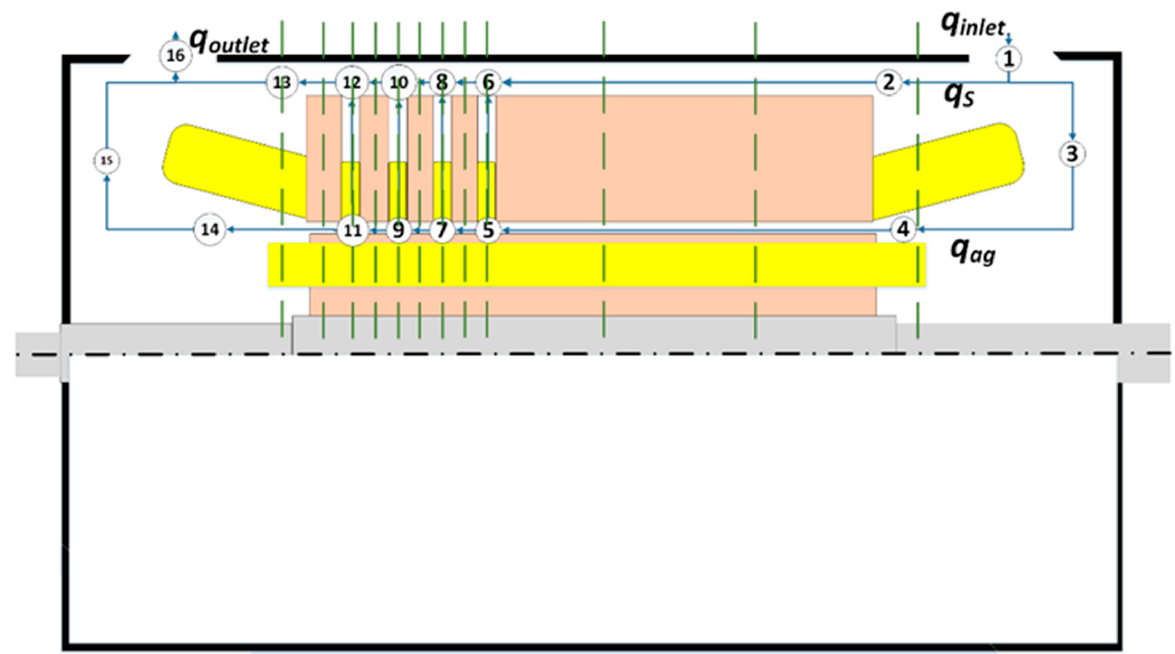
Figure 5. Stator’s coolant network.